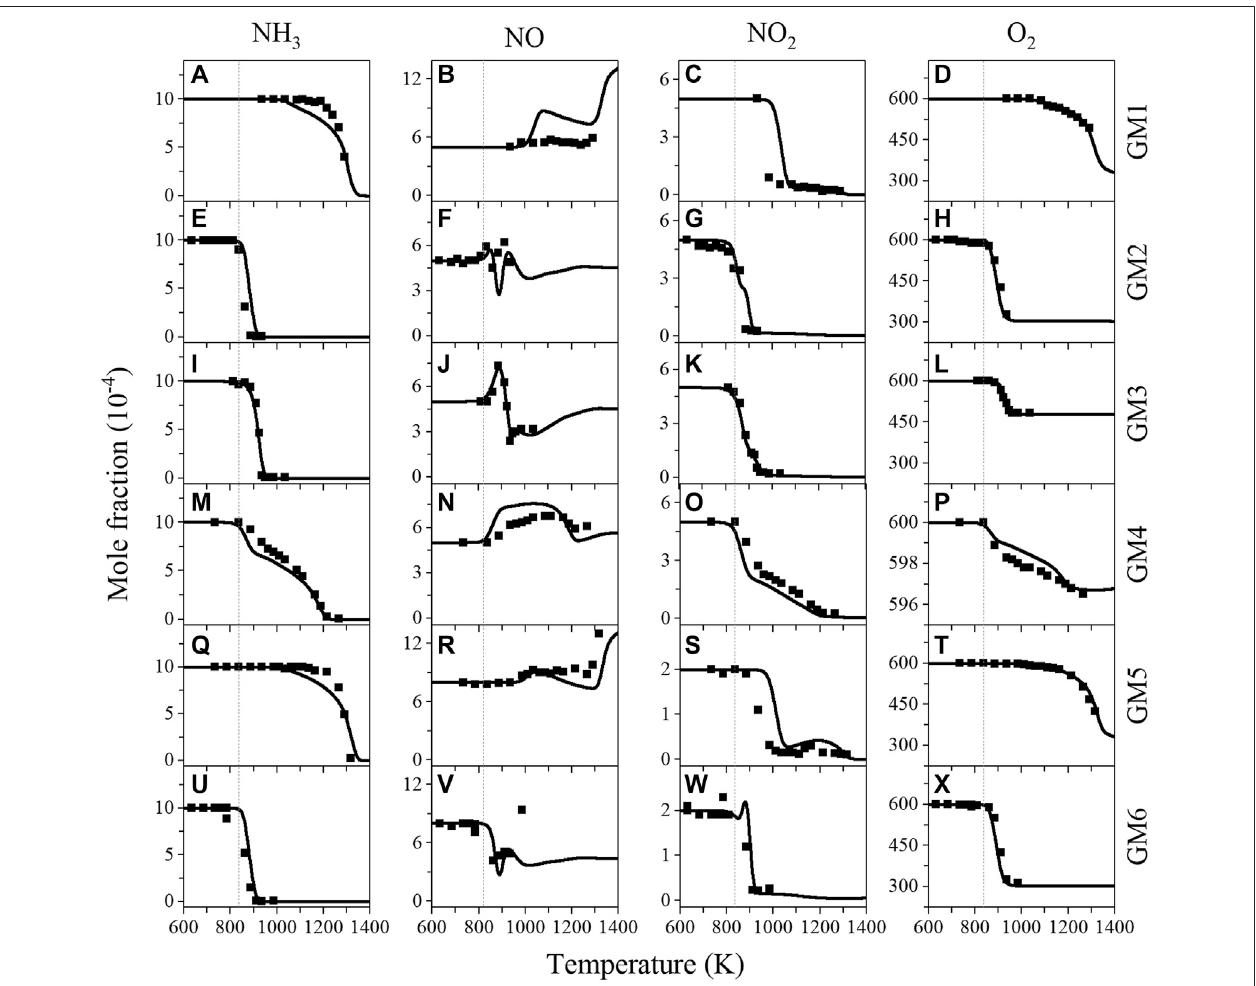
FIGURE1| Experimental(symbols)andsimulated(lines) molefraction pro fi lesofammonia(NH 3 ),nitricoxide(NO),nitrogendioxide(NO 2 )andoxygen(O 2 )fromthe oxidation of GM1-6. Experimental data of GM3-4 are taken from the work of Sun et al. (Sun et al., 2021).